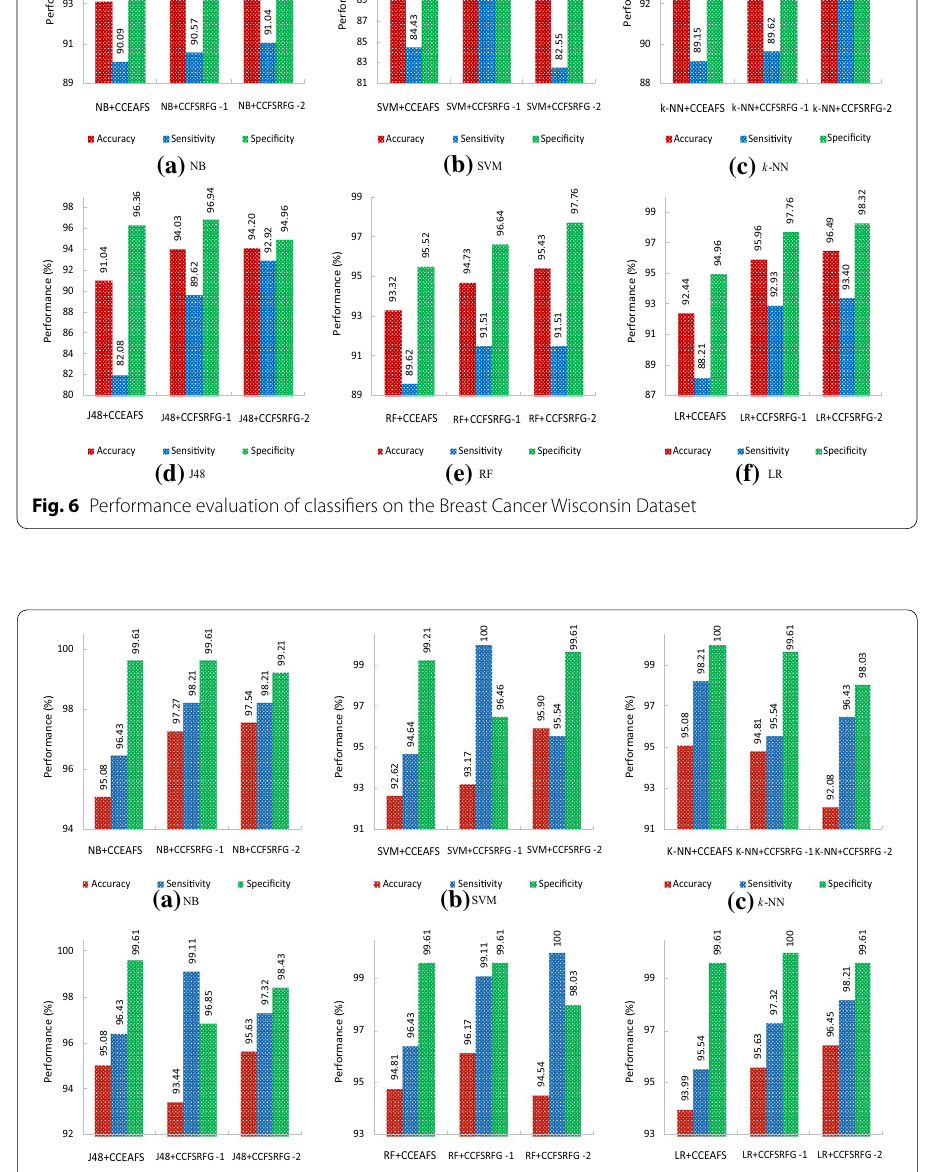
to collaborate with individuals from other subpopulations. In the subsequent genera- tions, the best individuals from the previous generation were used as the collaborators for evaluating an individual in a subpopulation. For CCFSRFG-2, in every generation, a